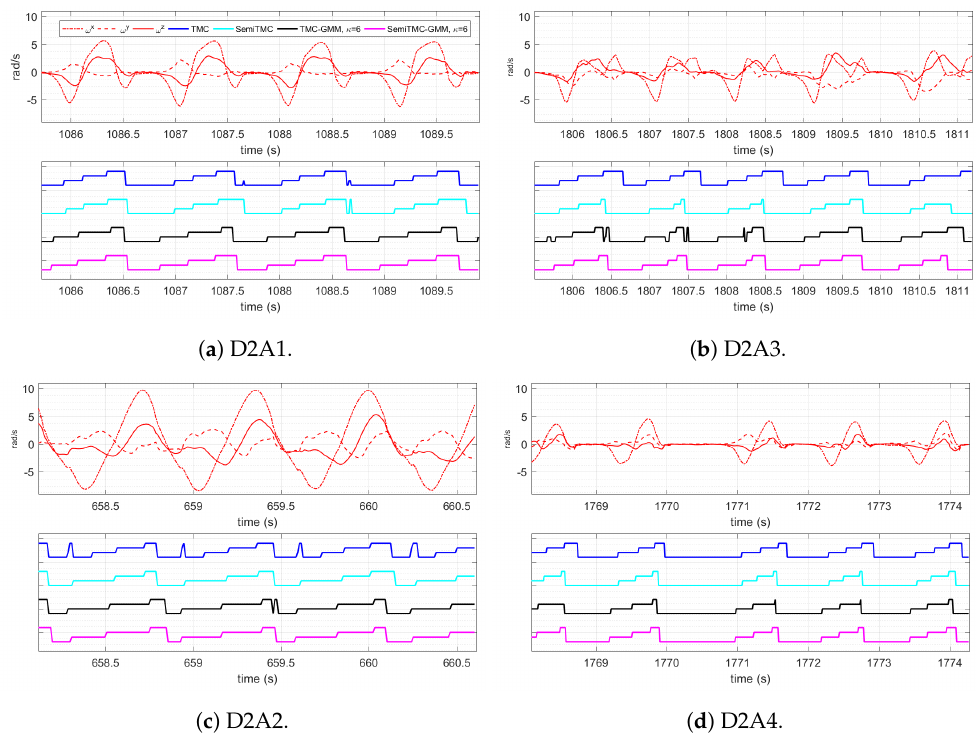
Figure 8. Estimated gait cycle of each activity. The blue, cyan, black, and magenta represent the gait obtained by TMC, SemiTMC, TMC-GMM, and SemiTMC-GMM,